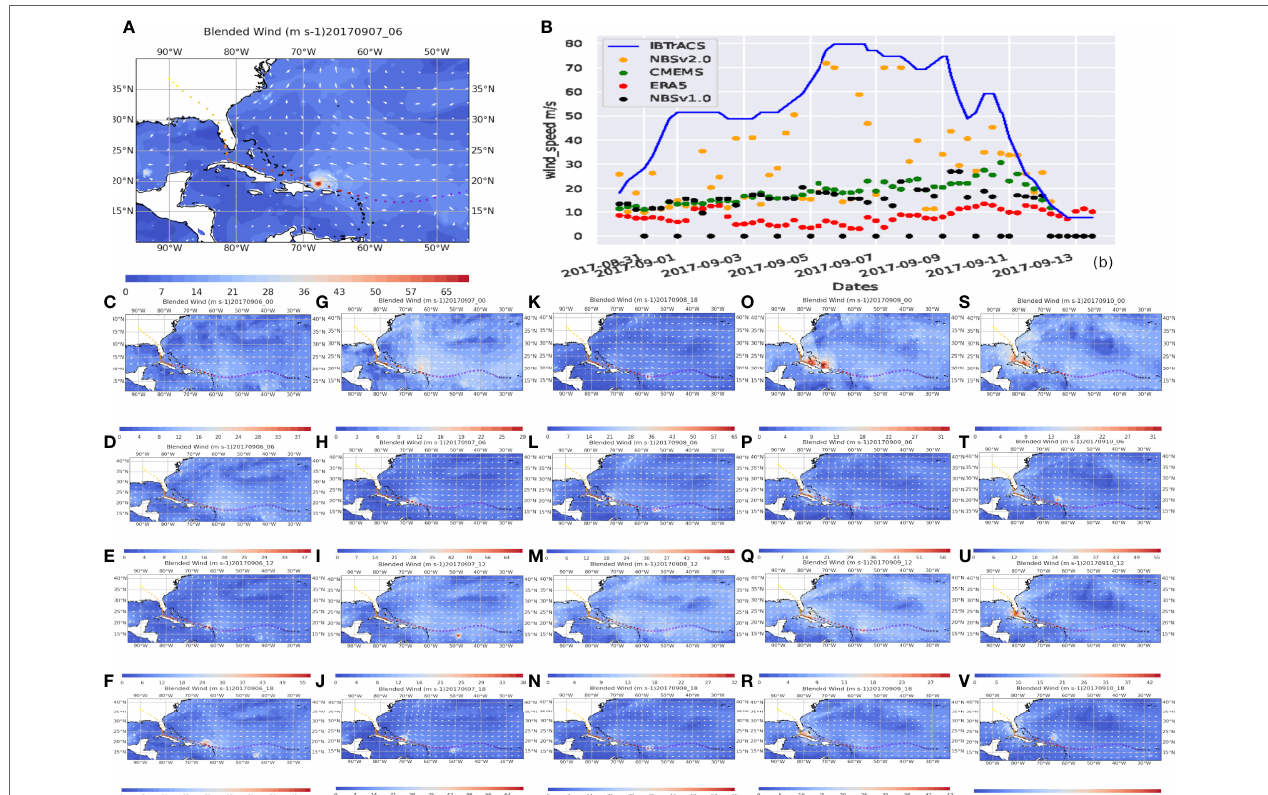
FIGURE 8 | (A) Peak wind speed day of Irma with best track available from IBTrACS data. (B) Time series of maximum wind along the track of Hurricane Irma. (C–V) Five days of wind data in and around the peak of the storm (on 7 September 2017), with different days (along the rows) and 4-hourly winds for each day (along the